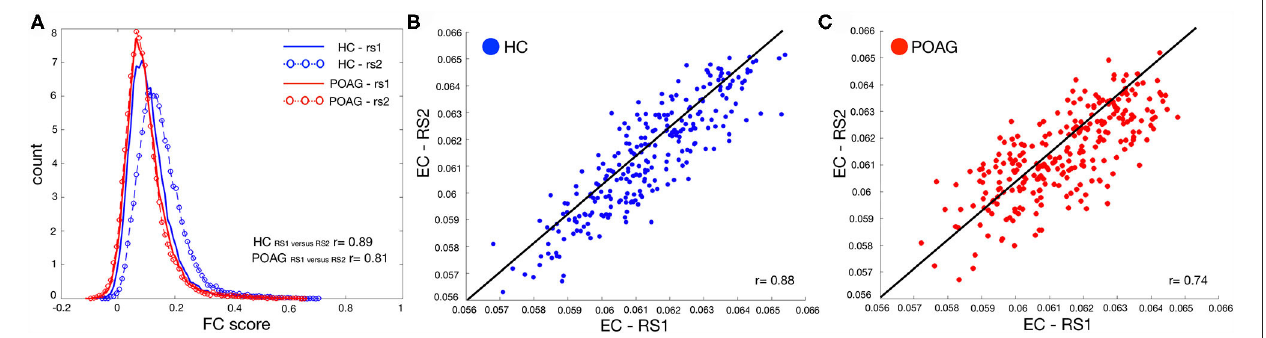
FIGURE 2 | Test-retest evaluation between RS scans for both FC and EC values. Panel (A) shows the histogram of the functional connectivity (FC) scores across all ROIs computed for both RS scans for control (blue line and circles) and POAG (red line and circles) participants. The y-axis label “count” represents the number of ROIs with a particular functional connectivity value. Panels (B,C) report the average EC values for control (blue) and POAG (red) groups, respectively. Each dot represents the average EC value for a single ROI defined based on the Power atlas. The black line represents the linear fit applied to the data.